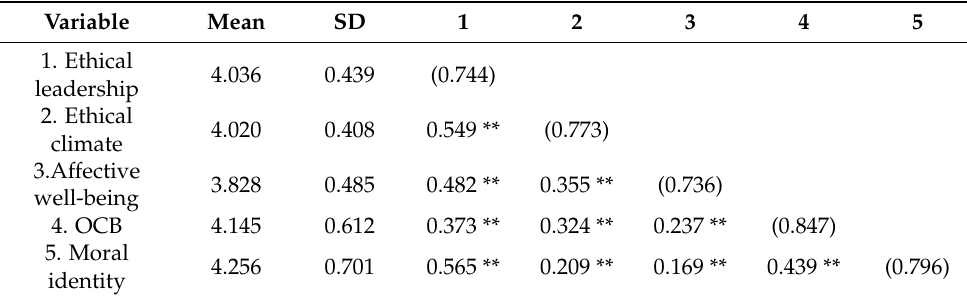
Table 2. Correlation matrix of the study variables.